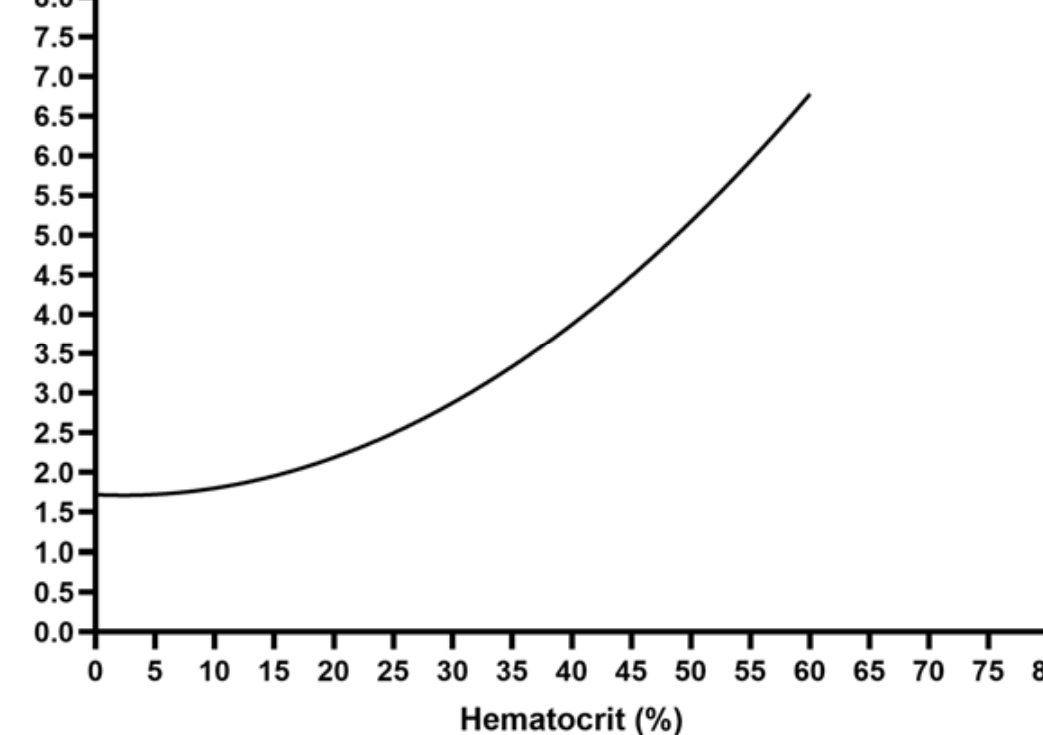
Figure 1. Relationship between hematocrit and blood viscosity.